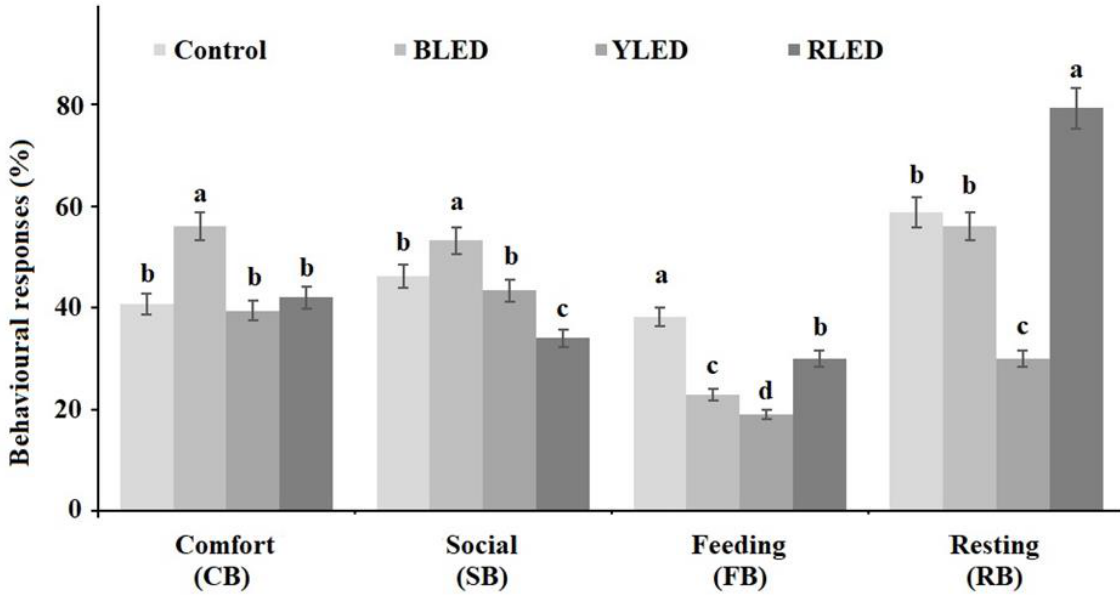
Figure 5. Comfort, social, feeding, and resting behaviours of the groups in their cages. a, b, c-different lowercase superscripts were significantly different at p <